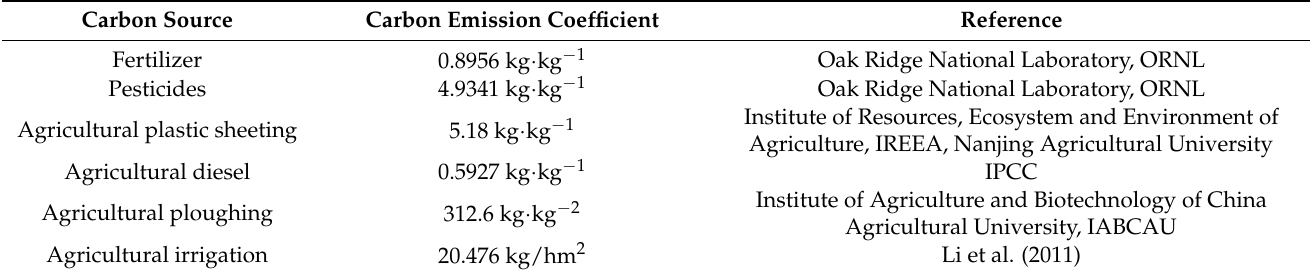
Table 2. Agricultural carbon emission source, coefficient, and